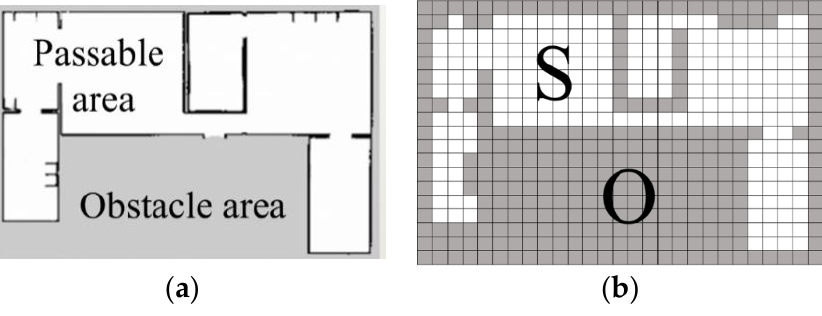
Figure 1. ( a ) Environment map; ( b ) grid map.